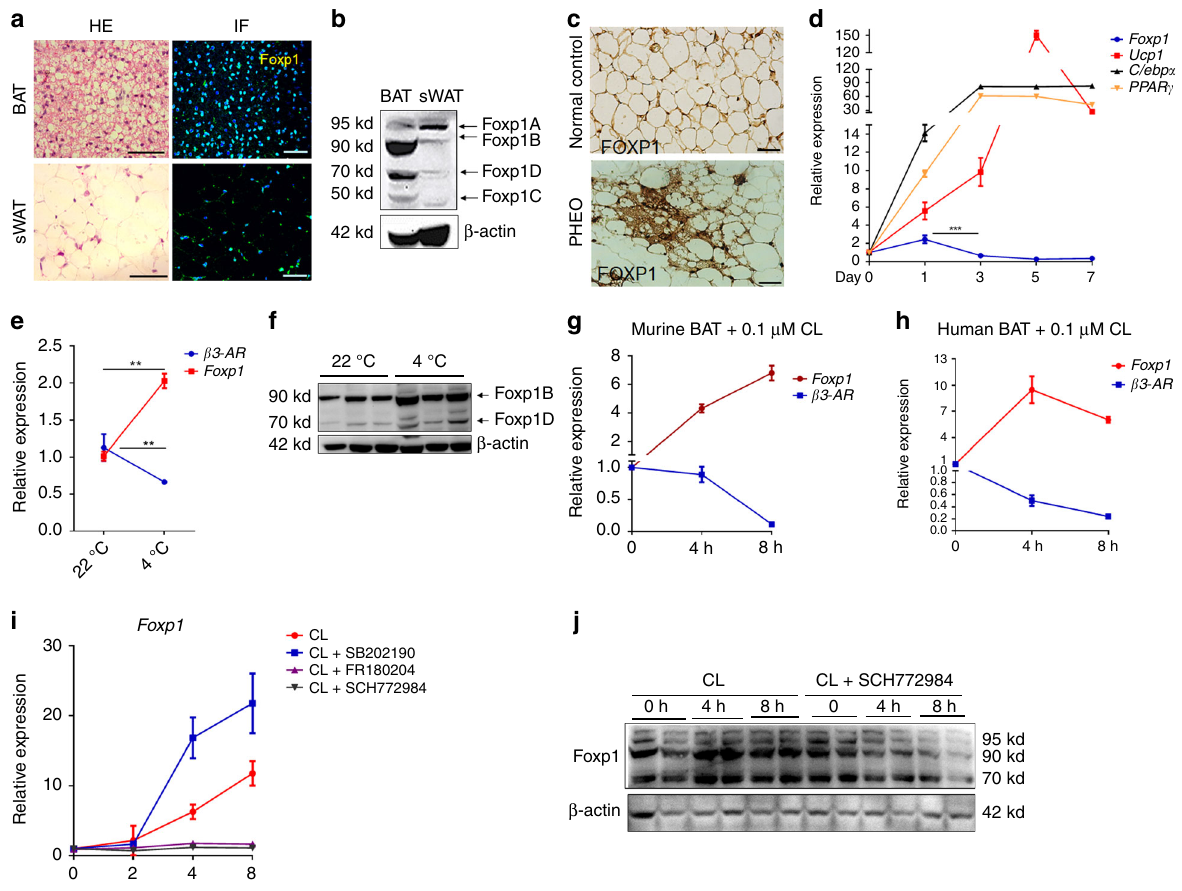
Fig. 1 Foxp1 expression in adipocytes is induced by adrenergic stimuli. a H&E staining and immuno fl uorescence (IF) analysis for the Foxp1 expression in BAT and sWAT from wild type mice at age of 4 weeks. DAPI, blue staining for nucleus; green color for Foxp1 expression. Bar, 50 μ m. b Western blotting showed the four isoforms (A, B, D, C) of Foxp1 protein in BAT and sWAT from wild type mice at age of 2 months. c IHC analysis of FOXP1 expression in biopsies from PHEO patients and normal controls. Bar, 10 μ m. d qPCR analysis of expression of Foxp1 and brown adipocyte markers ( C/ebp α , Ppar γ , and Ucp1 ) during the time course of brown adipocyte differentiation from SVFs. e qPCR analysis of Foxp1 and β 3-AR expression in BAT in mice with overnight 4 °C cold exposure. n = 3 biologically independent samples. f Western blotting of Foxp1 in BAT from mice above ( e ). g , h qPCR analysis of Foxp1 and β 3-AR expression in brown adipocytes differentiated from murine ( g ) and human SVF ( h ) during an 8-hour CL-316,243 (0.1 μ M) treatment as indicated. n = 3 biologically independent experiments. i Foxp1 expression pro fi le in adipocytes derived from 3T3-L1 cells during an 8-h time course, stimulated by CL- 316,243 (0.5 μ M) with or without SB202190 (p38 kinase inhibitor, 10 μ M), FR180204 (Erk1/2 inhibitors, 1 μ M) and SCH772984 (Erk1/2 inhibitors, 10 μ M), respectively. n = 3 biologically independent experiments. j Western blotting for Foxp1 in brown adipocytes derived from SVF, which were stimulated by CL- 316,243 (0.1 μ M) with or without SCH772984 (10 μ M) for 8 h. * P < 0.05; ** P < 0.01; *** P < 0.001; error bar, mean